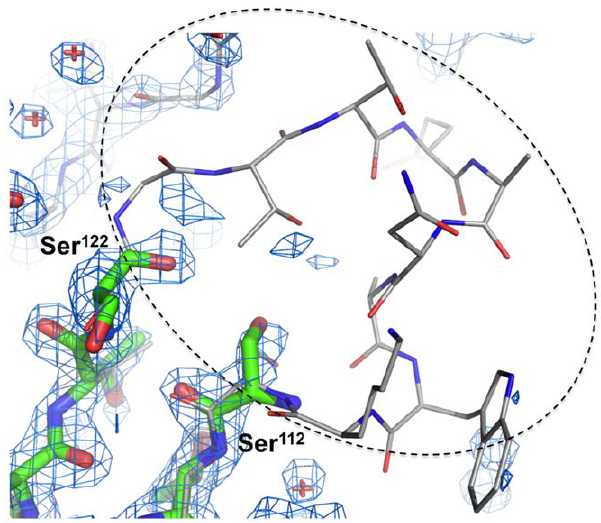
Figure 4. Electron density map (2| F o |-| F c | coefficients, con- toured at 1.1 sigma) contoured around the region expected to be occupied by residues 114–121 of loop 7–8 . The model for residues 110–112 and 122–124 fit the electron density quite well, but there is insufficient electron density to model residues 113–121. The structure of wild-type streptavidin (PDB code 1SWE) is superimposed and drawn in a thinner, gray line representation. Coefficients and phases were calculated using Refmac and the figure was prepared using PyMOL.